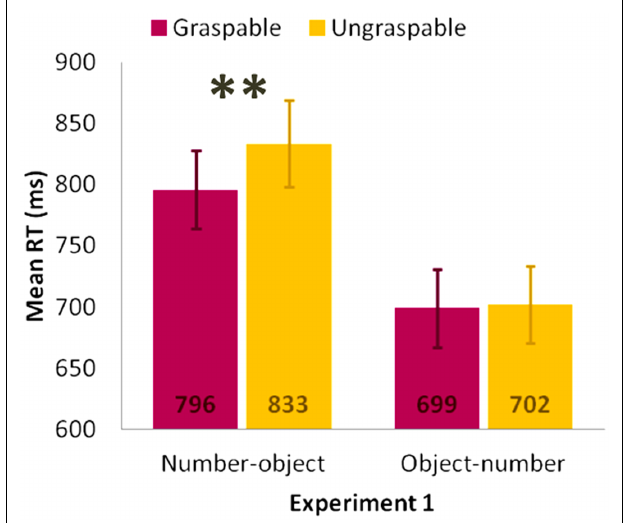
FIGURE 2 | Significant Order × Object type interaction for RTs in Experiment 1, values are in ms and bars are SEM. Significant comparisons are indicated with *(p < 0.05) or **(p < 0.01).